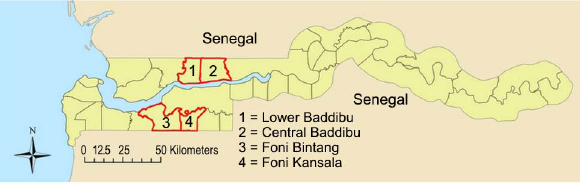
Figure 2. Location of PRET study districts within The Gambia.